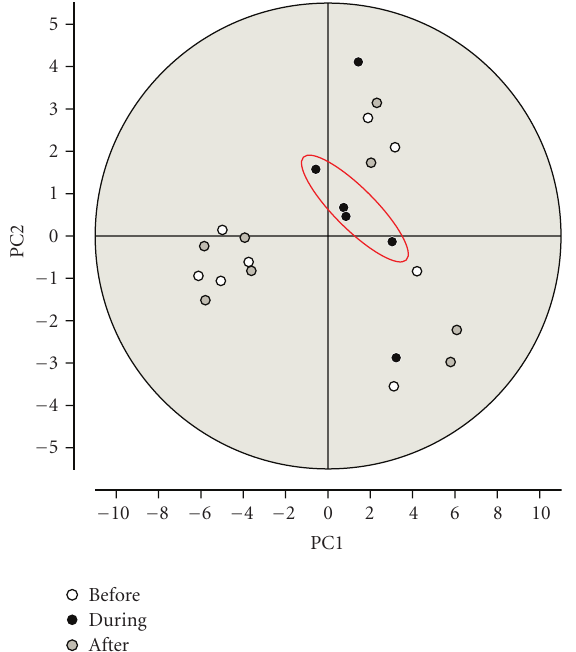
Figure 8: Principal component analysis of during-treatment spot maps originating from the two di ff erent statins: pravastatin (statin A) and rosuvastatin (statin